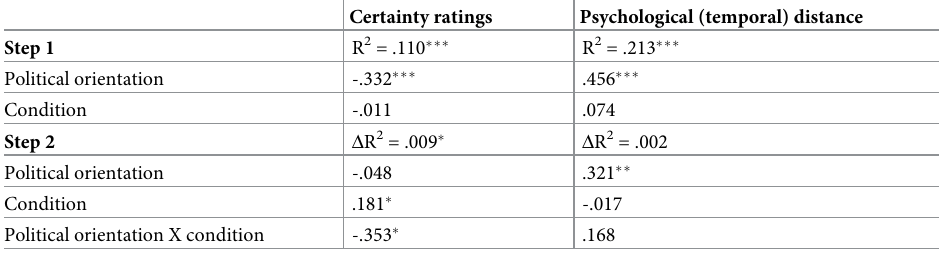
Table 2. Standardized regression coefficients regressing each explanatory variable on political orientation, condi- tion, and the interaction